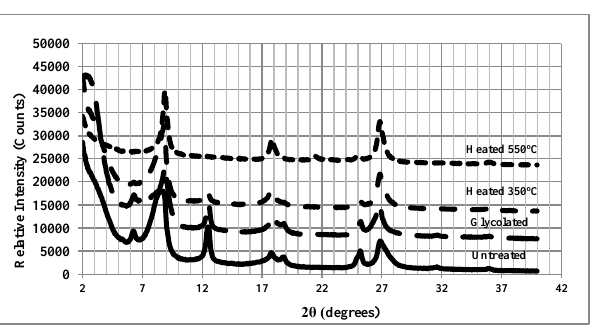
Figure 6: X-ray diffractograms of sample from Outcrop 8 (Scans R 4919)